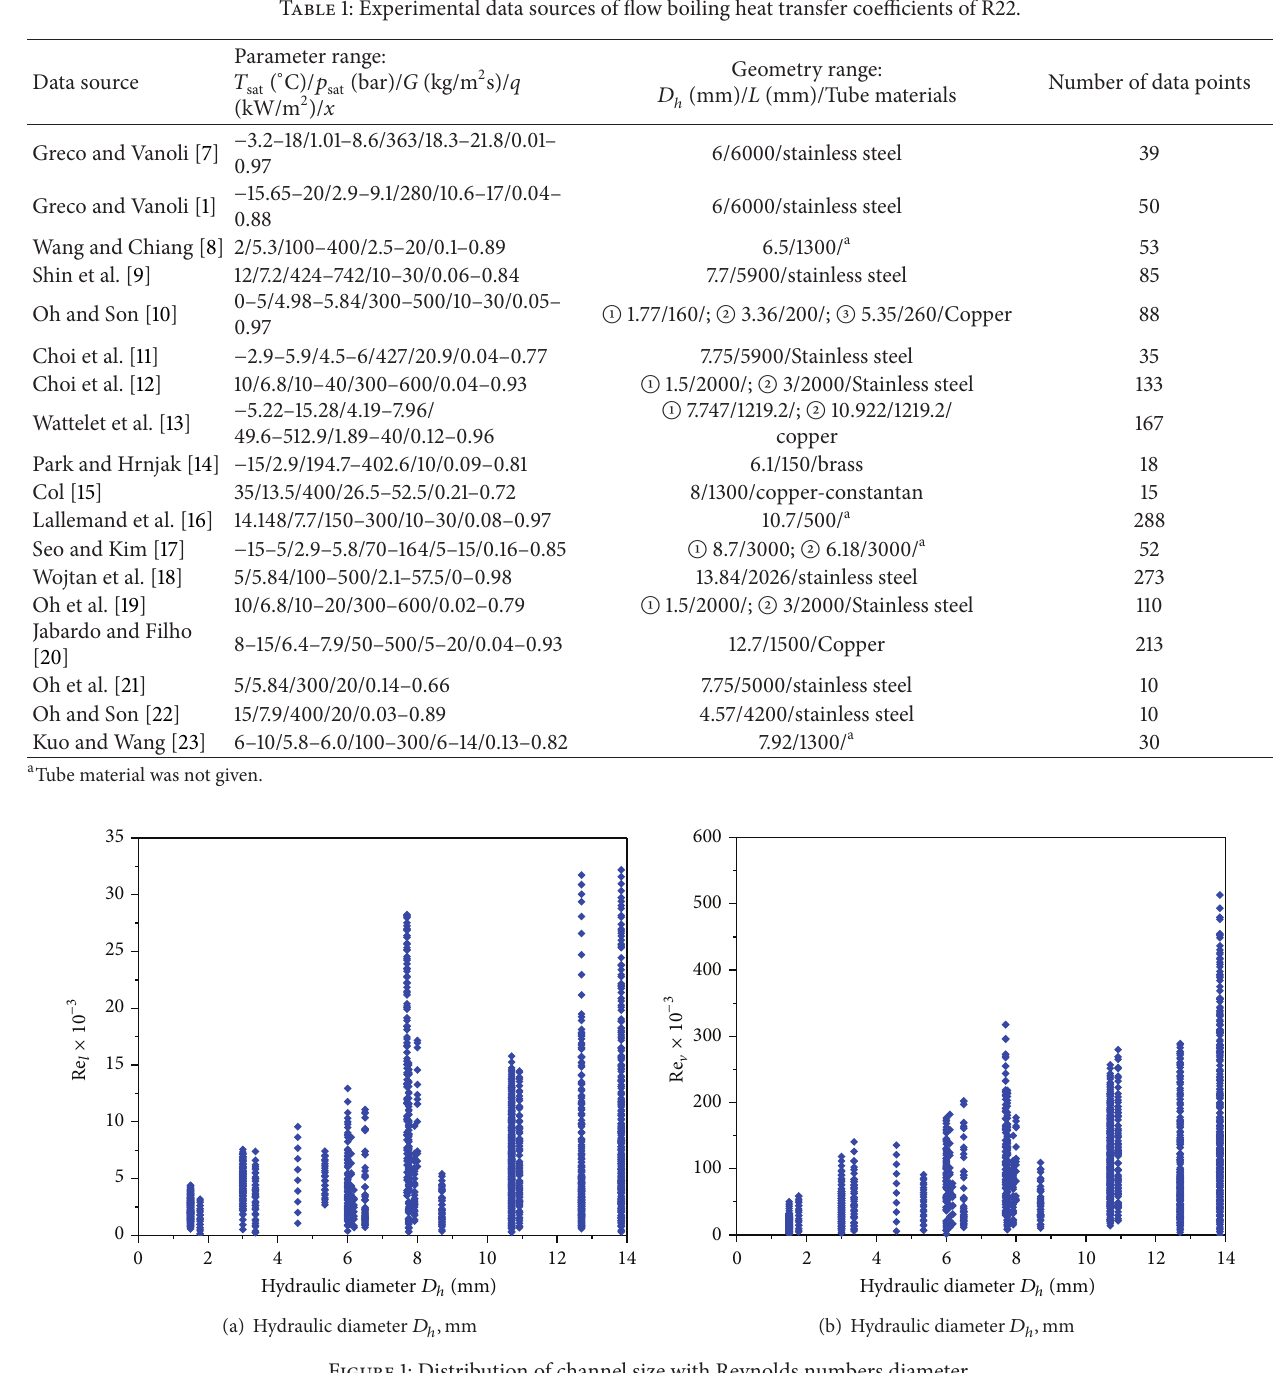
Table 1: Experimental data sources of flow boiling heat transfer coefficients of R22.